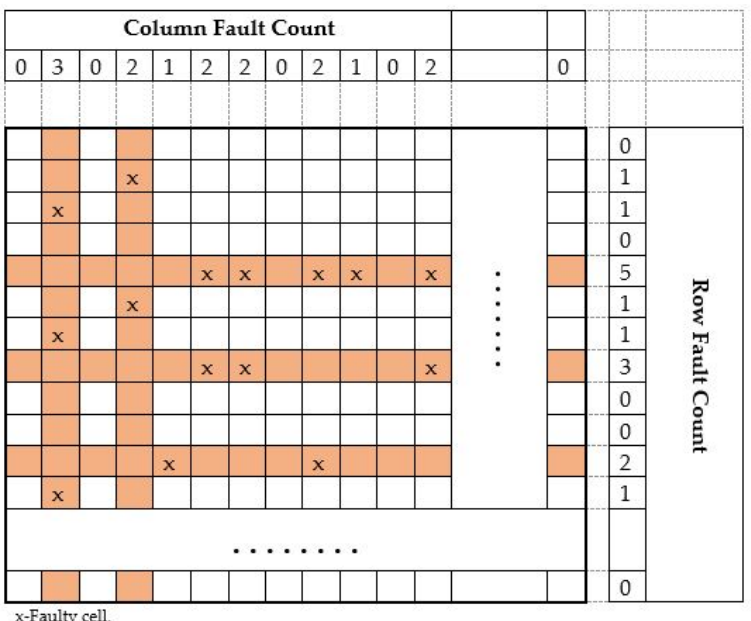
Figure 7. Total fault count row ‐ wise and column ‐ wise 16 Kbytes memory.